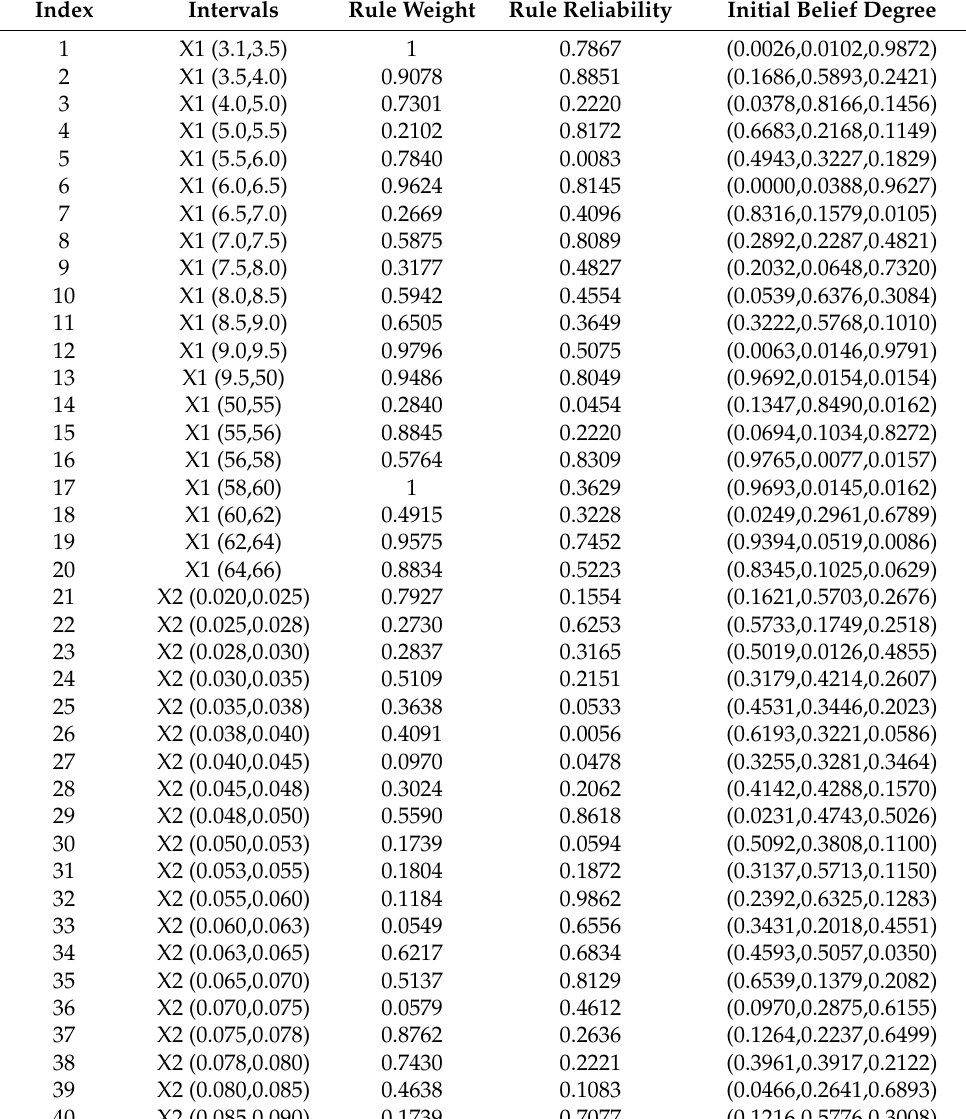
Table A2. The rule weight, rule reliability and belief degree of the proposed model after